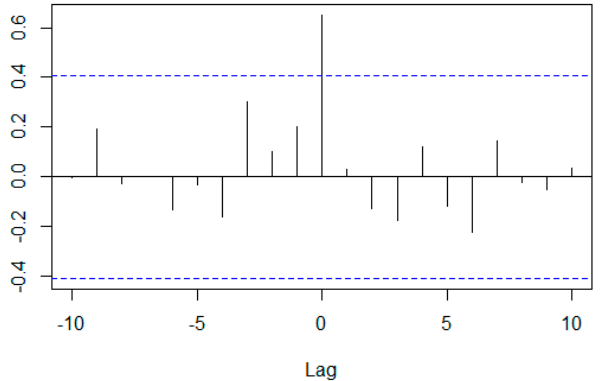
Figure 7. Cross-correlation coefficient between the average CAR of the whole sample group and the average CAR of the camera group for Evaluation period: the month in which each company was listed - 2008, Event period: 2010–2012.